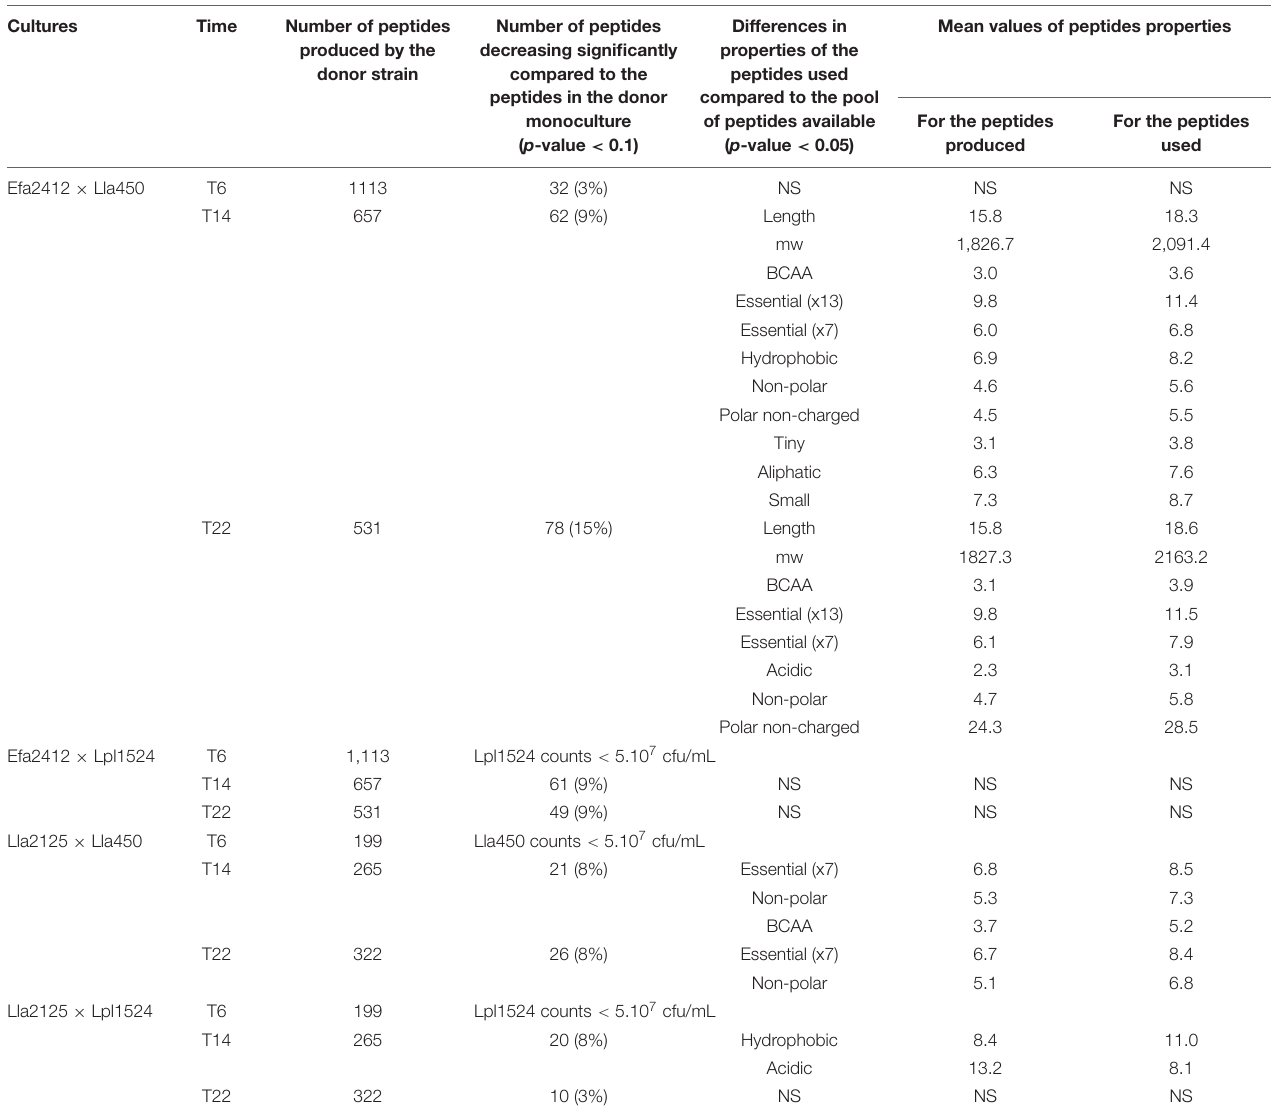
TABLE 3 | Comparison of peptide abundances in the monocultures of the donor strains Efa2412 and Lla2125 and their co-cultures with the receiver strains Lla450 or Lpl1524. Cultures Time Number of peptides